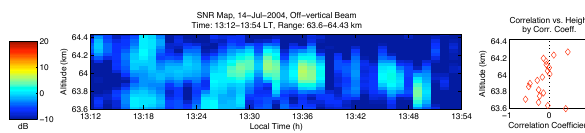
R. Sheth et al.: Radar study of mesospheric fine structure Fig. 13. A turbulent layer at 72.8km on 13 July at 15:01 LT. Fig. 13. A turbulent layer at 72.8 km on July 13 at 15:01 LT. Fig. 10. Two thin structures at 73.2 and 75 km on May 29 starting at 11:50 and 12:50 LT, respectively. correlations found in the entire data set for May 27 and 28.